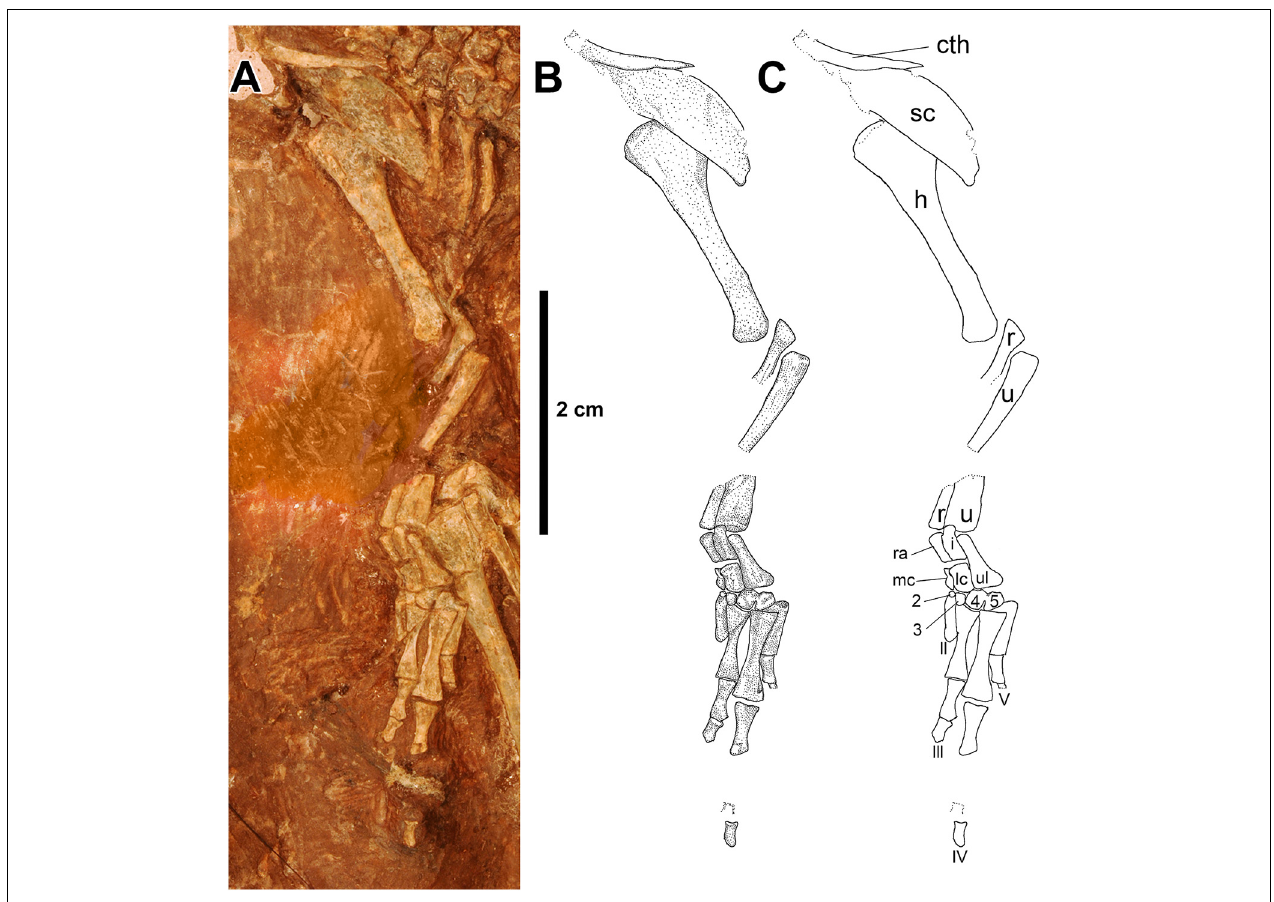
FIGURE 6 | Eudibamus cursoris , holotype (MNG 8852). (A) Photograph, (B) illustration, and (C) labeled outlines of elements of forelimb and shoulder girdle in dorsal